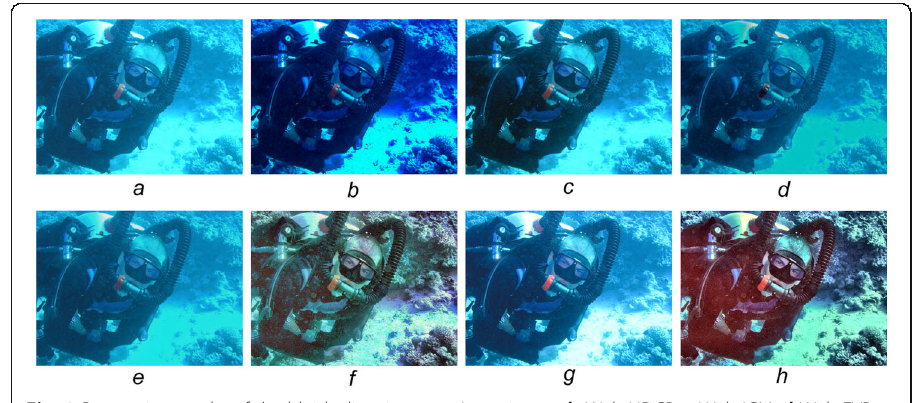
Fig. 9 Restoration results of the bluish diver image. a Input image. b With UDCP. c With ICM. d With FVR. e